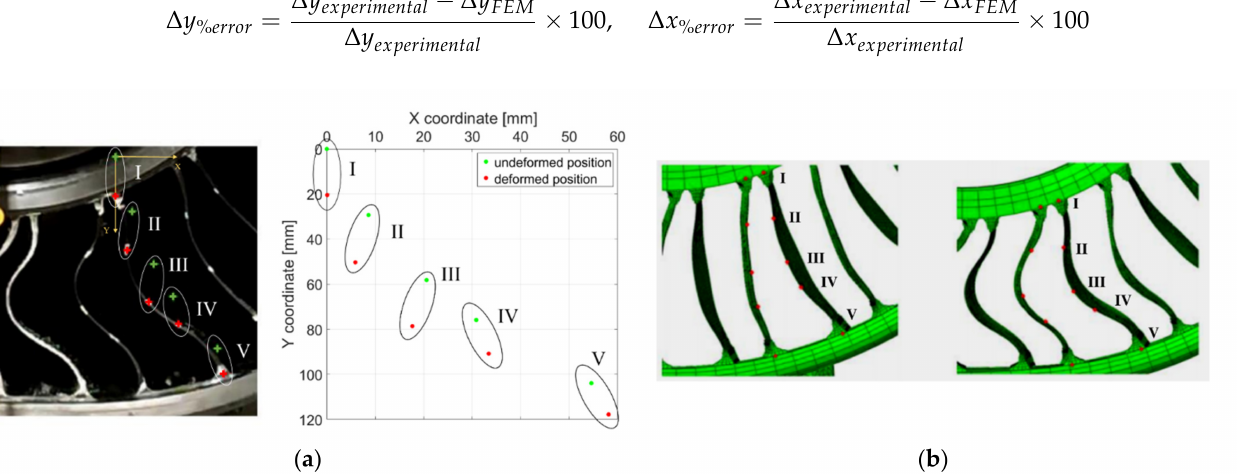
Figure 11. DIC tool markers: ( a ) marker position in undeformed and deformed state on tire (left) and coordinate axis system (right); ( b ) marker position in undeformed (left) and deformed (right) state in FE model. Table 3. DIC tool and FEA displacement values and percentage errors. Spokes